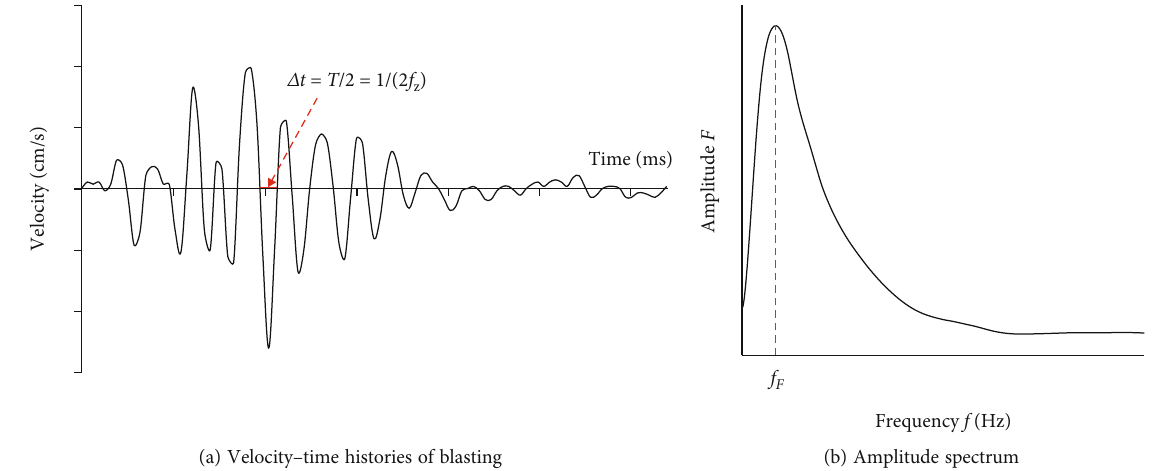
Figure 1: Typical waveform and spectrum of blasting vibration.